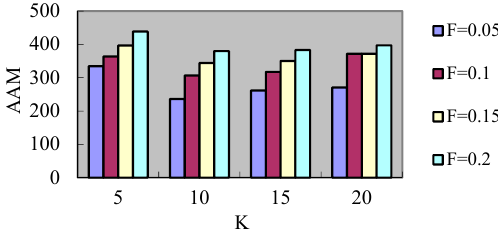
Figure 9. Test for a suitable value of K.